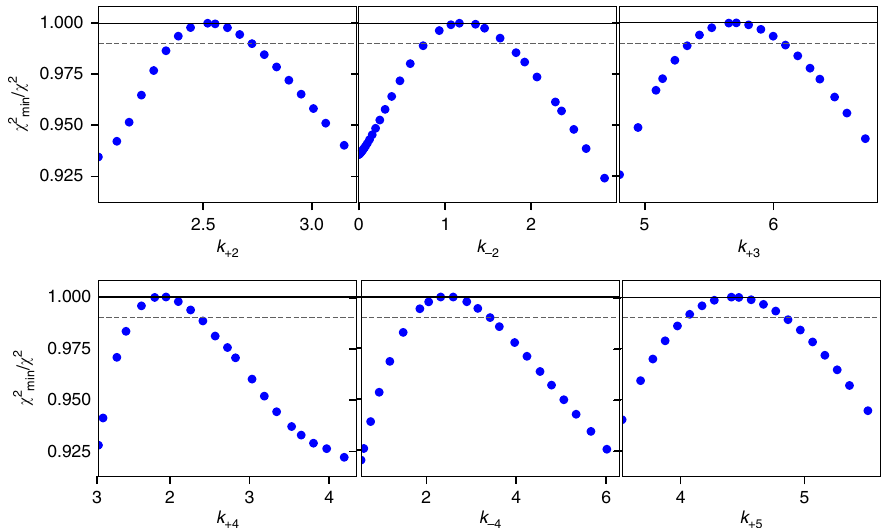
Fig. 6 Con fi dence contour analysis for global data fi tting. Con fi dence contours are shown for fi tting data in Fig. 5. Numbered rate constants are de fi ned in our kinetic model (Fig. 5f, inset). The χ 2 threshold (dashed line) was set to 0.99 to de fi ne upper and lower limits for each rate constant as described 17,32 . Because the contours were symmetrical with parameters well constrained, we report ± error limits in Table 1. For this analysis a χ 2 threshold was calculated using an F-distribution and was used to de fi ne the lower and upper limits for each